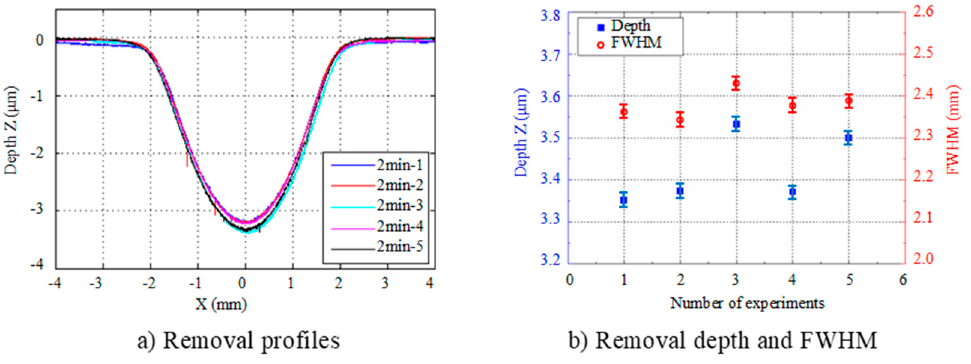
Figure 3. Repeatability of the APPP removal function.